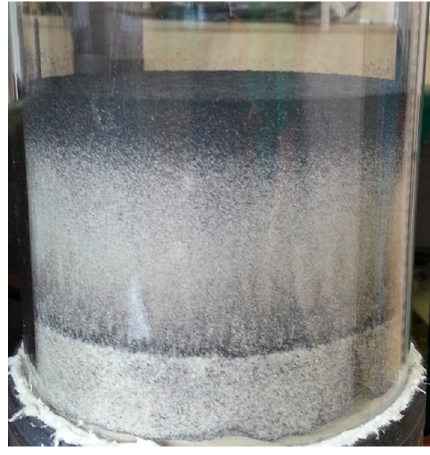
Figure 3. Results of FB separation. Table 1. FB separation mass balance, g.